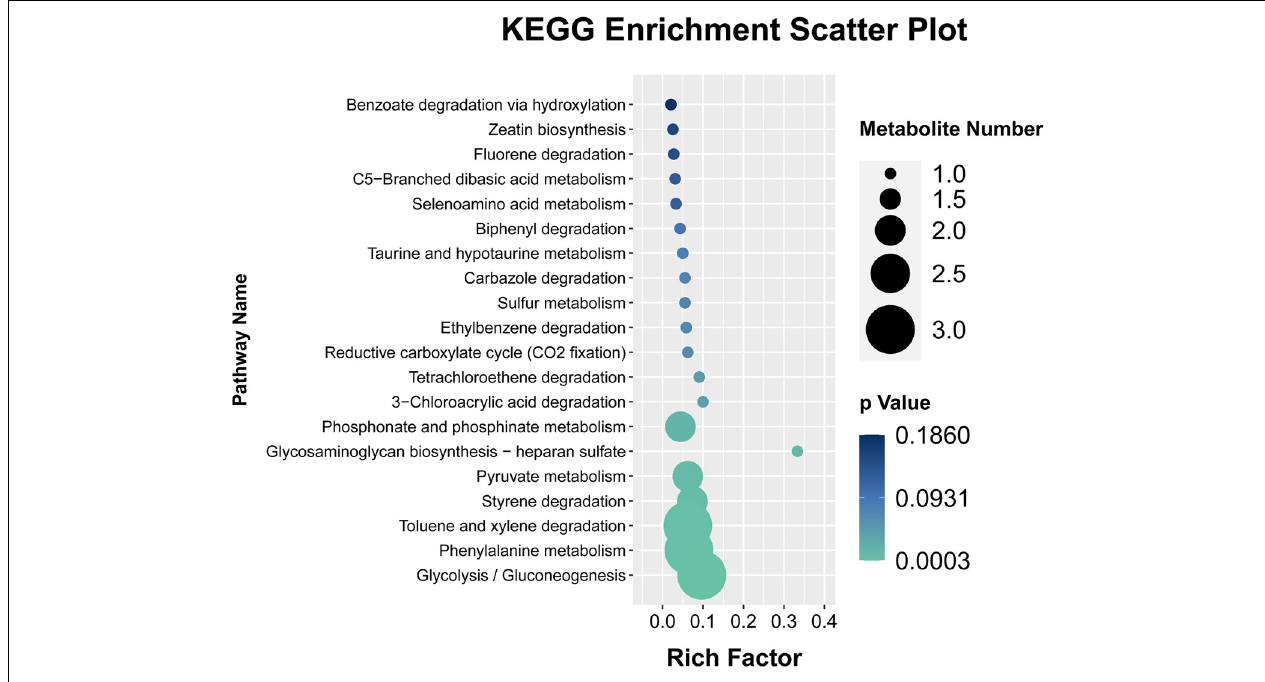
FIGURE 7 | KEGG pathway enrichment of identified differential metabolites.